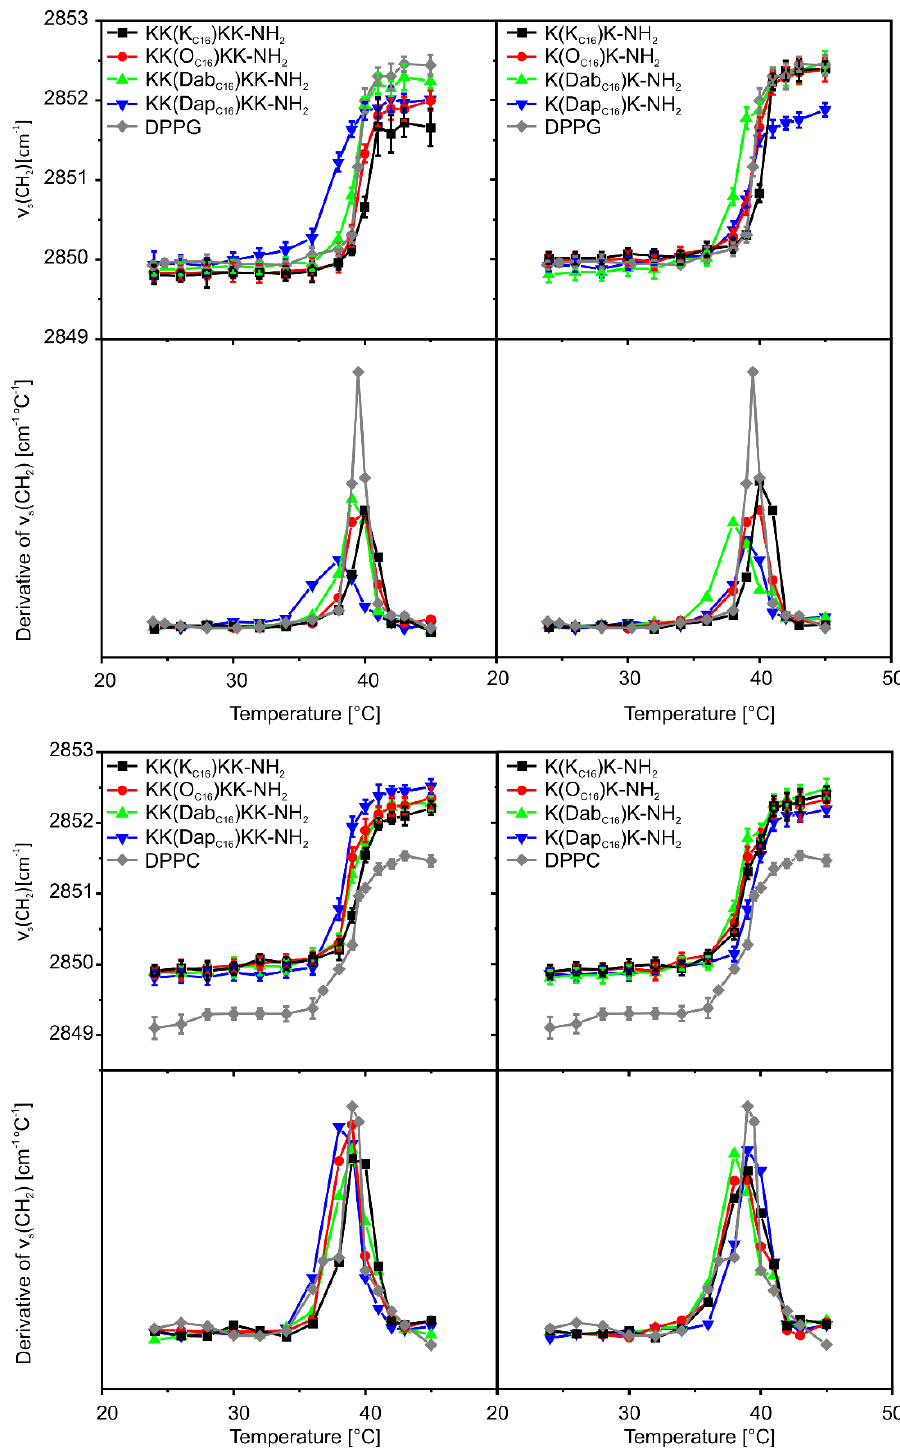
Figure 4. 1,2-Dipalmitoyl- sn -glycero-3-[phospho-rac-(1-glycerol)] (DPPG) and 1,2-dipalmitoyl- sn - glycero-3-phosphocholine (DPPC) melting curves determined as the temperature dependent changes in the position of the ν s (CH 2 ) stretching bands of the lipid acyl chains in the Fourier transform infrared (FTIR) spectra with and without the added lipopeptides. The peak maxima in the bottom panels indicate transition temperature.